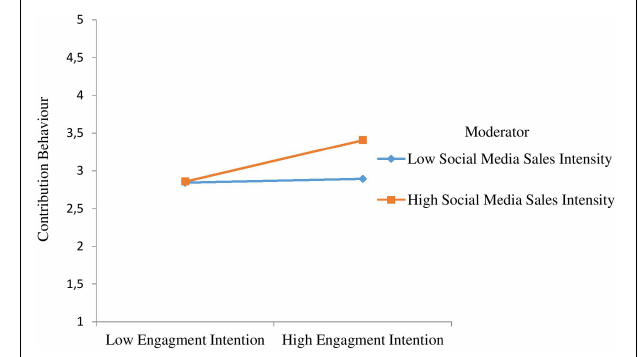
FIGURE 3 | Interactive effects of engagement intention and social media sales intensity on consumption behaviour.